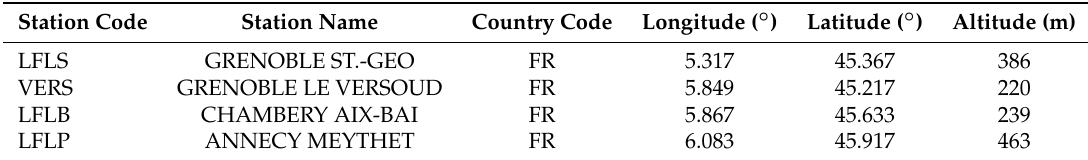
Table 3. List and location of meteorological stations.